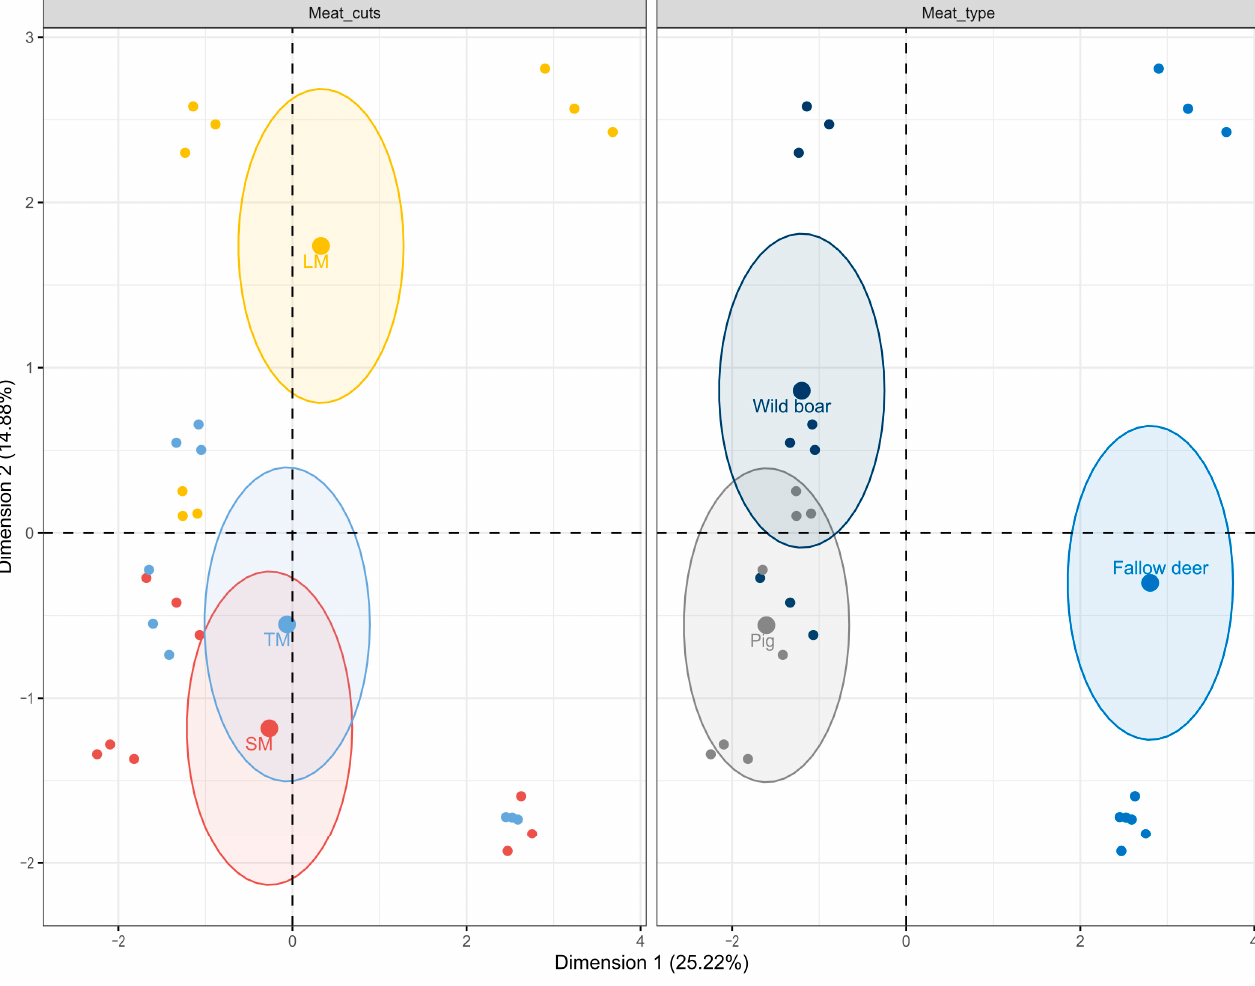
Figure 1. The combined graph of individuals with visualized meat cuts and meat type factors. LM: loin meat; SM: shoulder meat; TM: thigh meat samples.